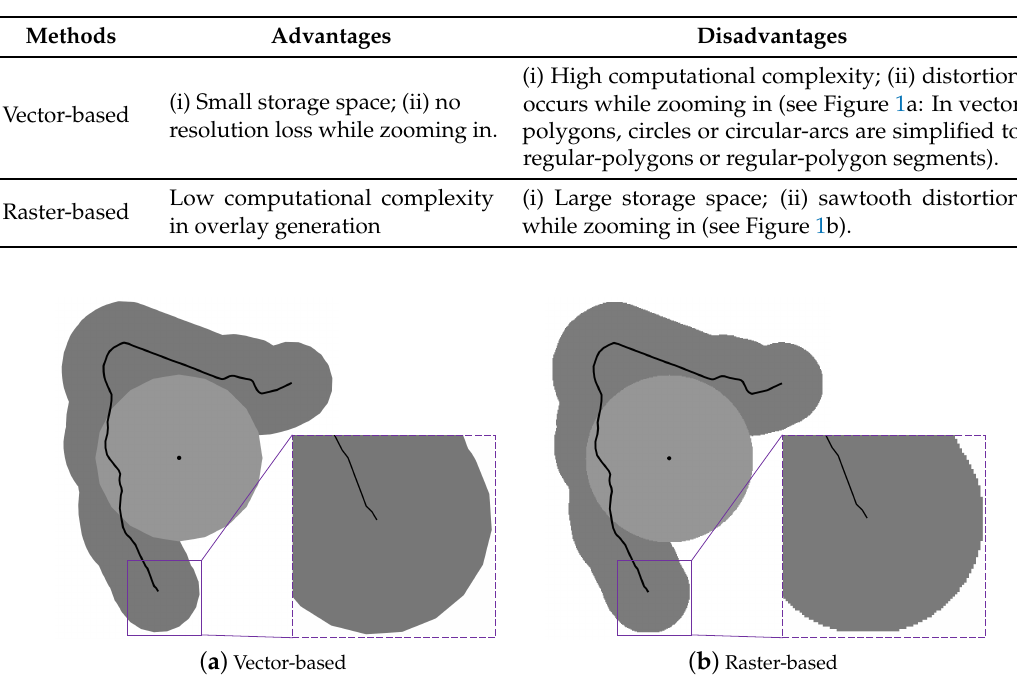
Table 1. Advantages and disadvantages of traditional methods.